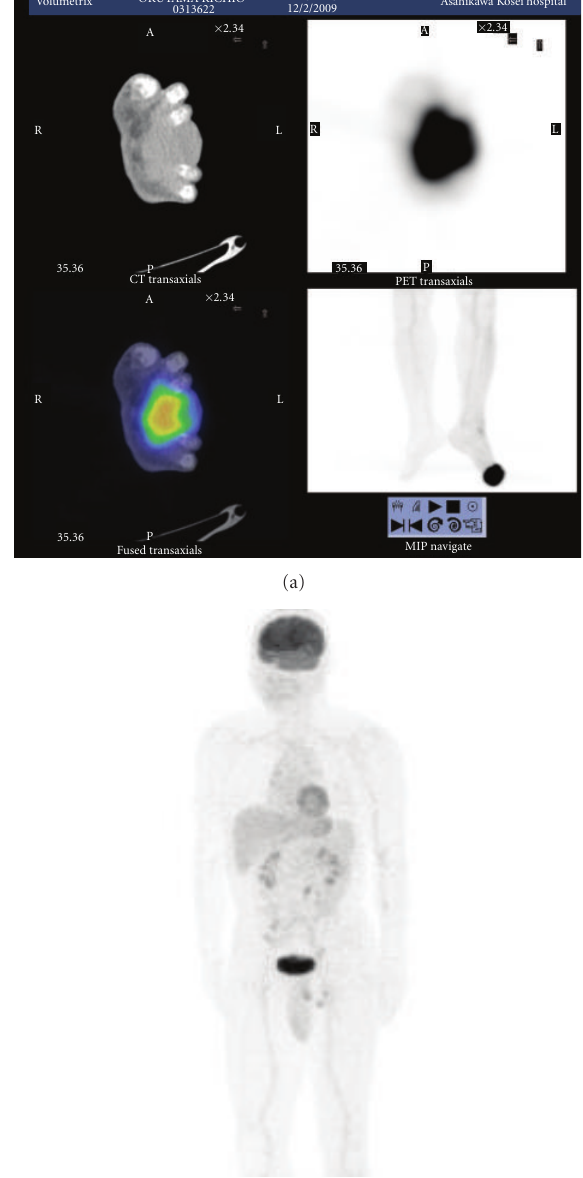
Figure 2: Preoperative positron emission tomography. (a) Abnor- mal uptake involving the a ff ected foot. (b) No abnormal uptake was observed except left inguinal